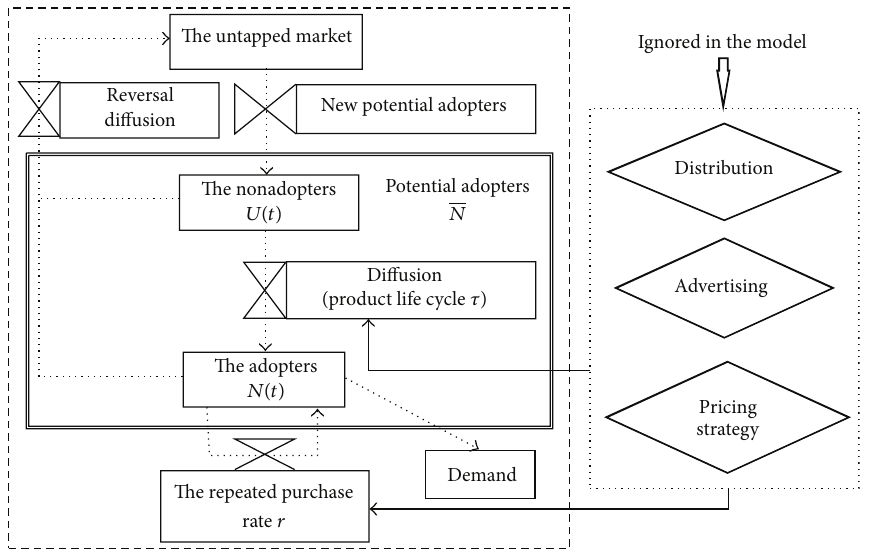
Figure 1: The diffusion process for